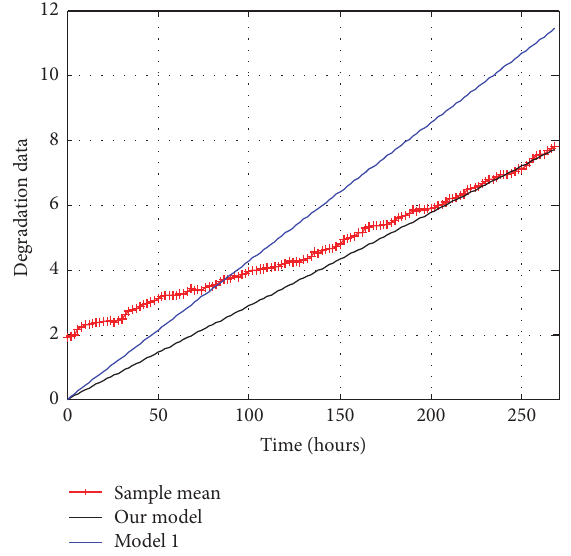
Figure 15: Comparison of the estimated mean degradation